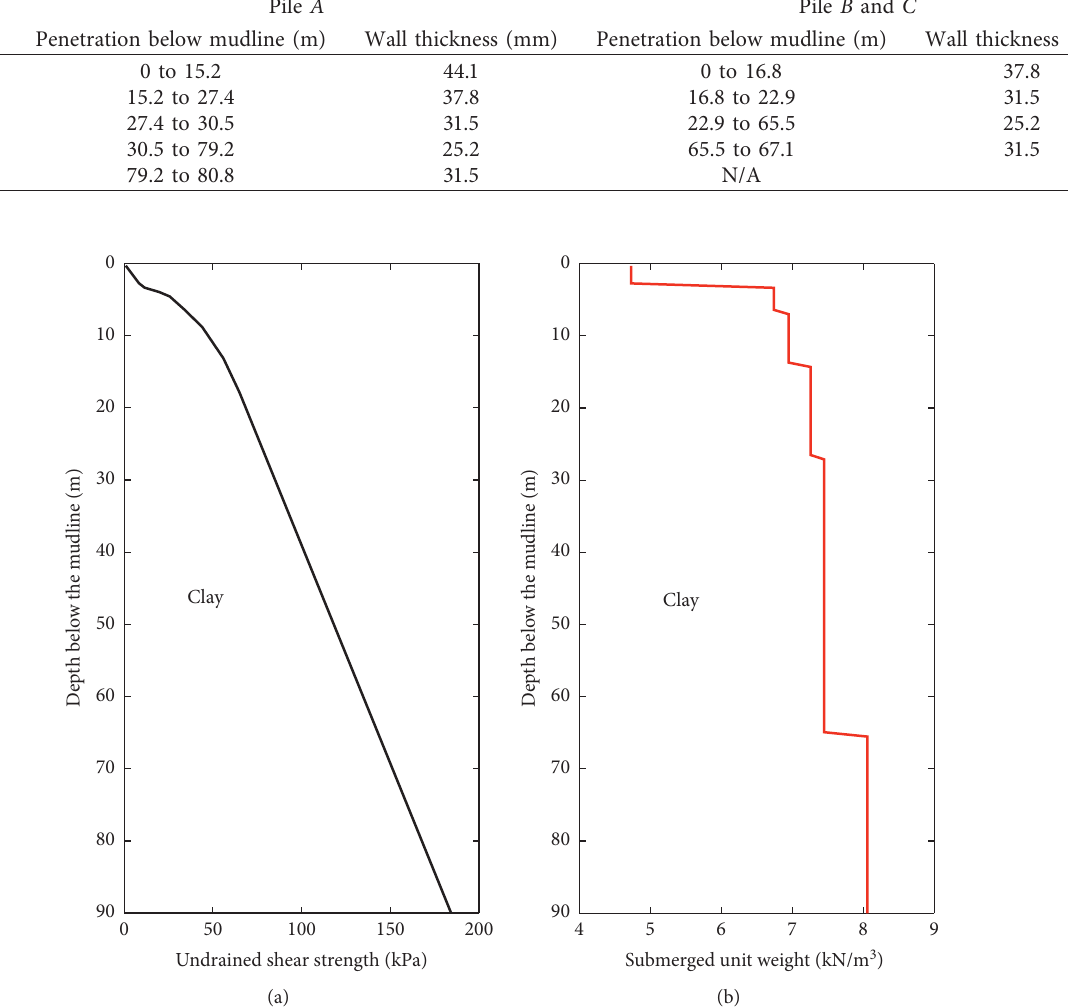
Figure 5: Design undrained shear strength and submerged unit weight profiles.